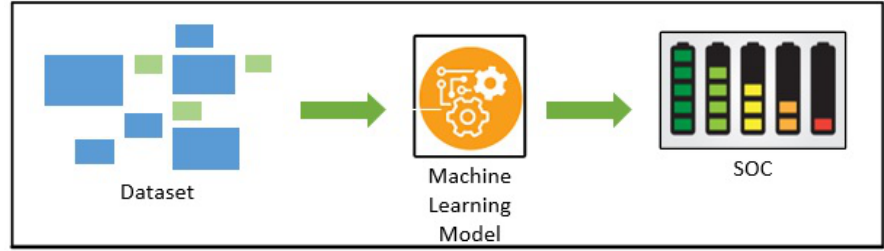
Figure 2. Block diagram of machine learning for SOC estimation.